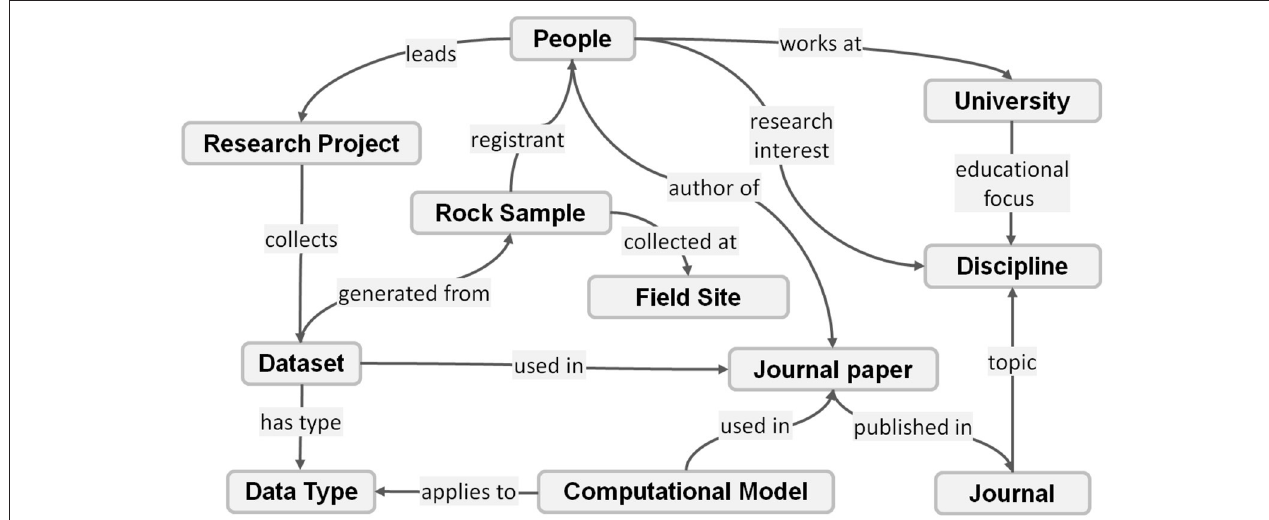
FIGURE 1 | A fragment of a network showing part of the agents, entities and activities involved in scientific